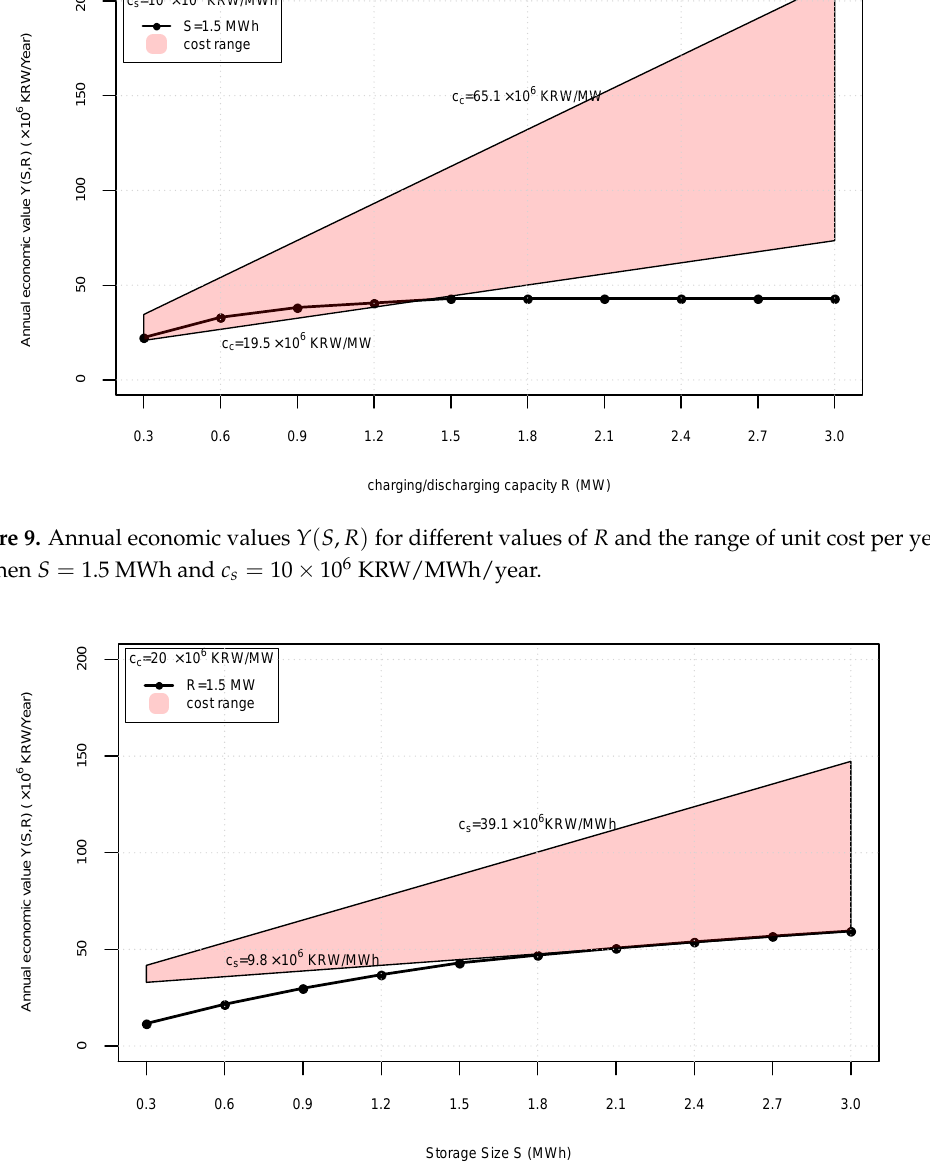
Figure 10. Annual economic values Y ( S , R ) for different storage sizes and the range of unit cost per year c s when R = 1.5 MW and c r = 20 × 10 6